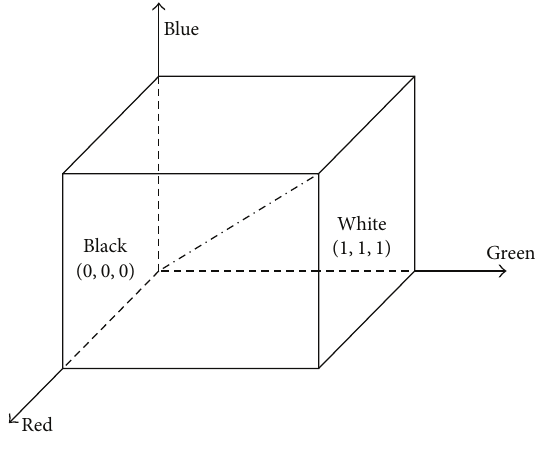
Figure 3: RGB color space